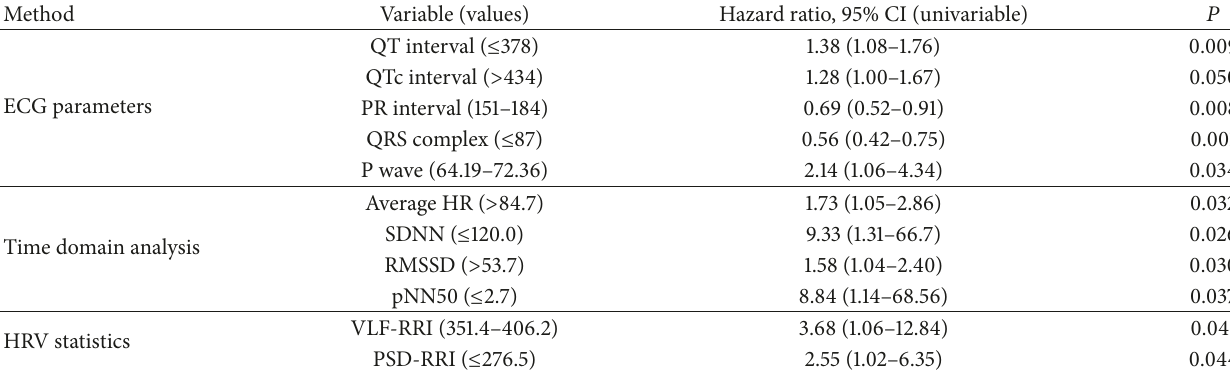
Table 2: Association of risk variables with cardiac mortality in univariable analysis.